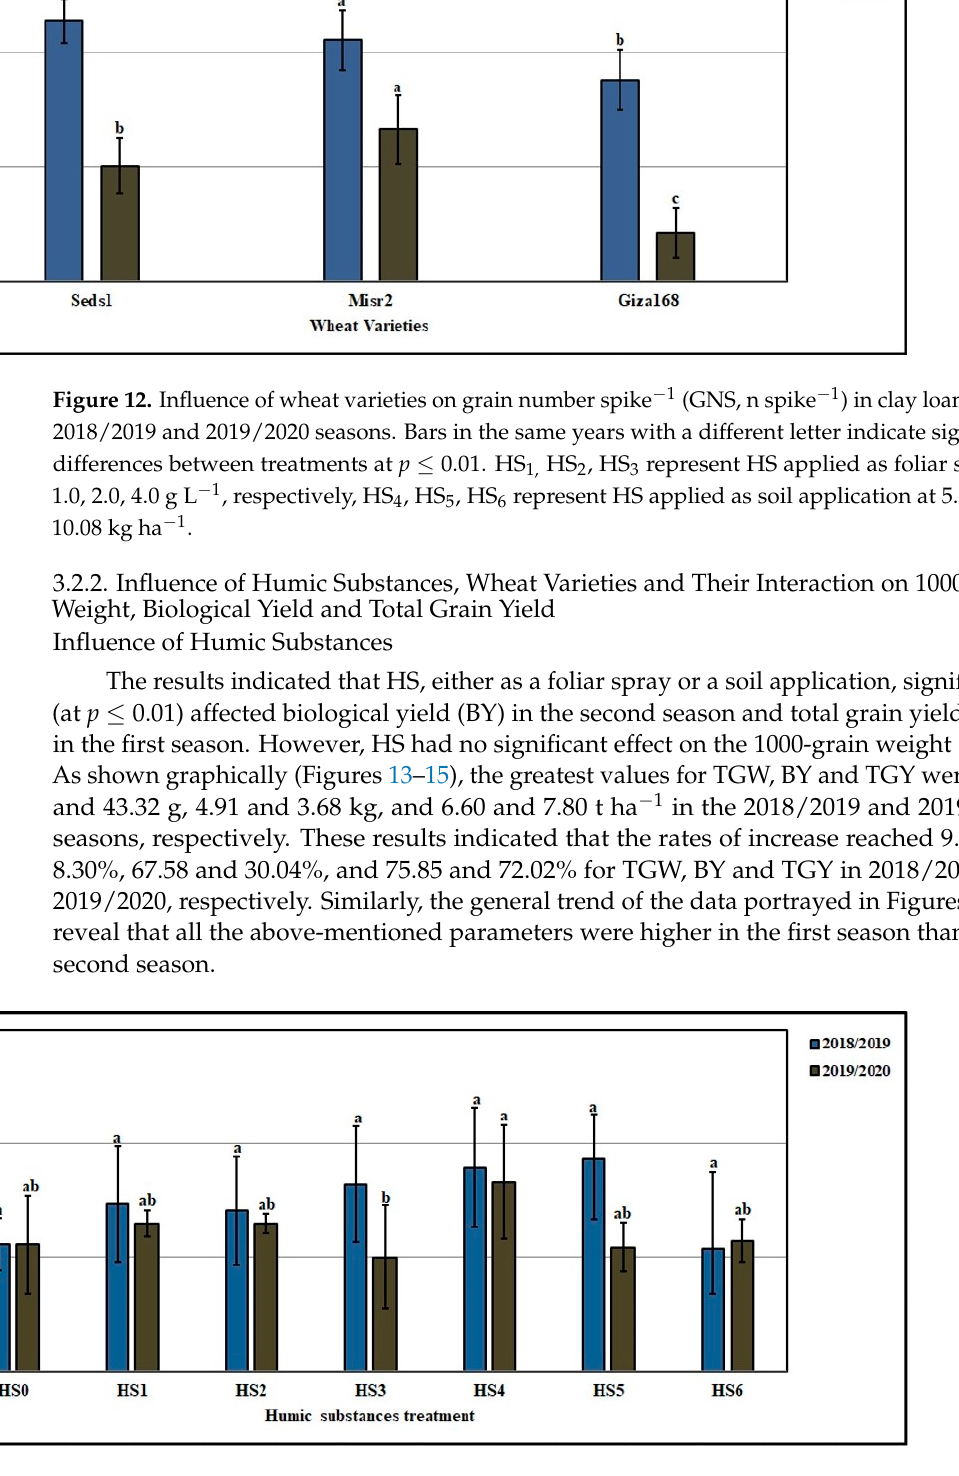
Figure 13. Influence of humic substances treatments on 1000-grain weight (TGW, g) of some wheat varieties grown in clay loam soil in 2018/2019 and 2019/2020 seasons. Bars in the same years with a different letter indicate significant differences between treatments at p ≤ 0.01. HS 1, HS 2 , HS 3 represent HS applied as foliar spray at 1.0, 2.0, 4.0 g L − 1 , respectively, HS 4 , HS 5 , HS 6 represent HS applied as soil application at 5.04, 7.56, 10.08 kg ha − 1